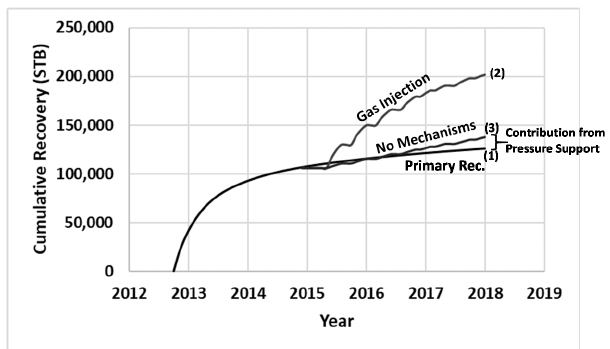
Figure 11. Cumulative recovery from basic flow simulation runs for primary production, gas injection, and gas injection with the mechanisms turned off.